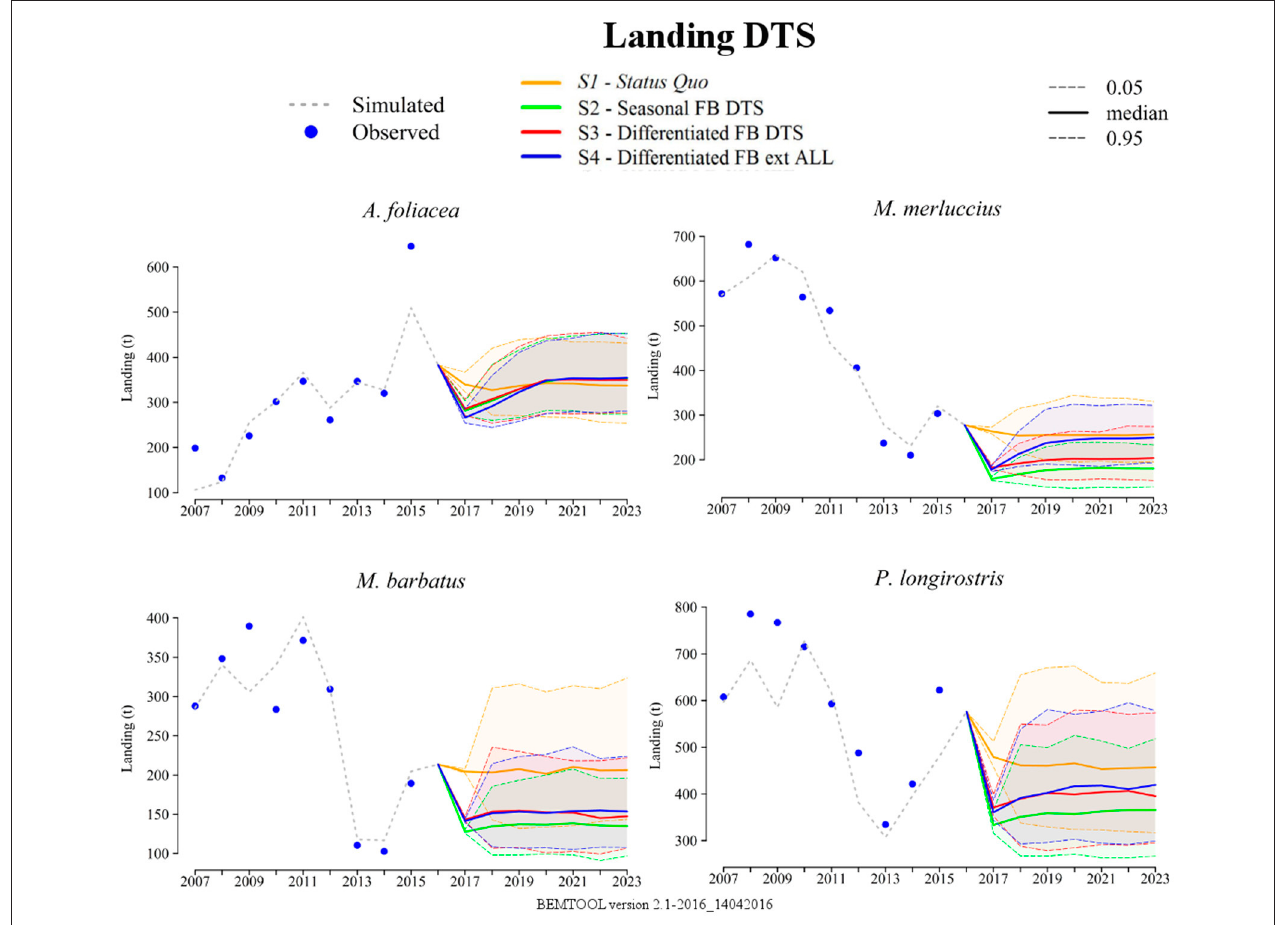
FIGURE 6 | Comparison among the scenarios of landings (trawlers) by target stocks in the hindcasting (2007–2016) and forecasting (2017–2023) timelines. Dotted line, Hindcasting from the bioeconomic modeling tool (BEMTOOL); Blues points, observed landing (DCF data).